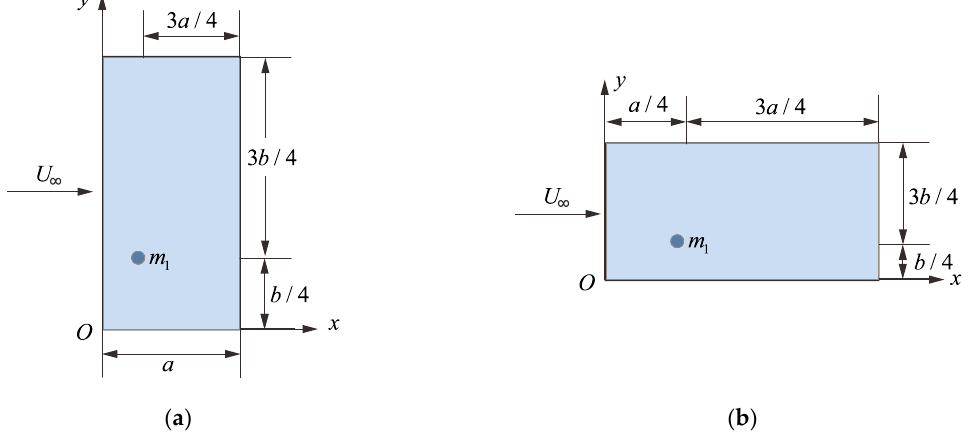
Figure 19. Effects of the two damper schemes on flutter characteristics of the panel: ( a ) U F − g , f c . ( b ) f F − c . F